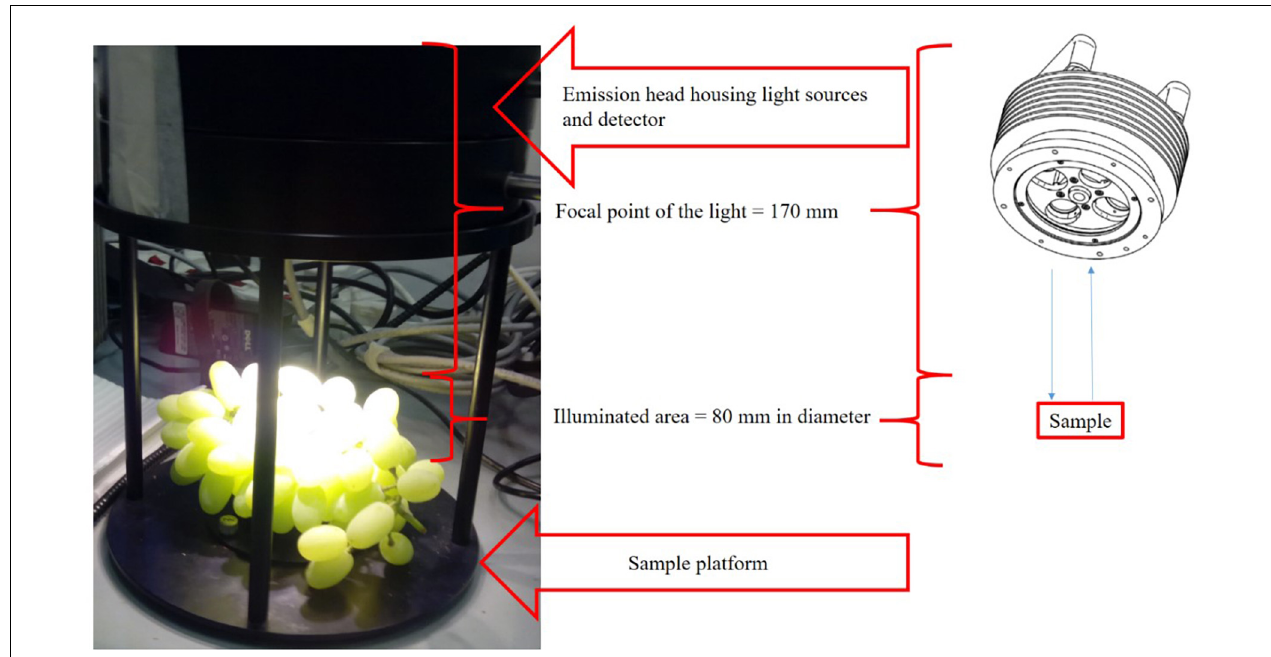
FIGURE 1 | Contactless scanning of an intact ‘Thompson Seedless’ table grape bunch with the MATRIX-F NIR spectrometer (adapted from Daniels et al.,